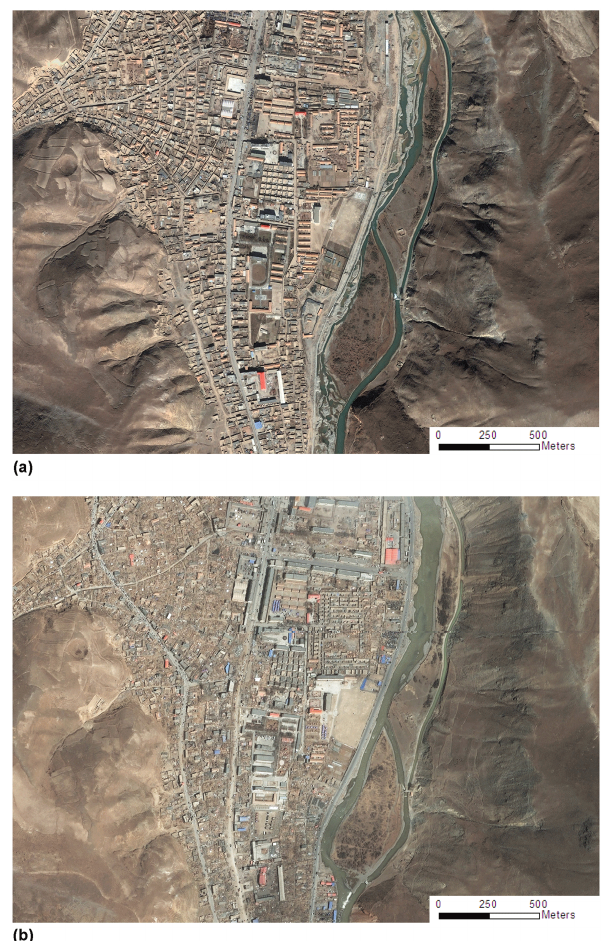
Figure 5. Pre- and post-seismic QuickBird images of the Yushu